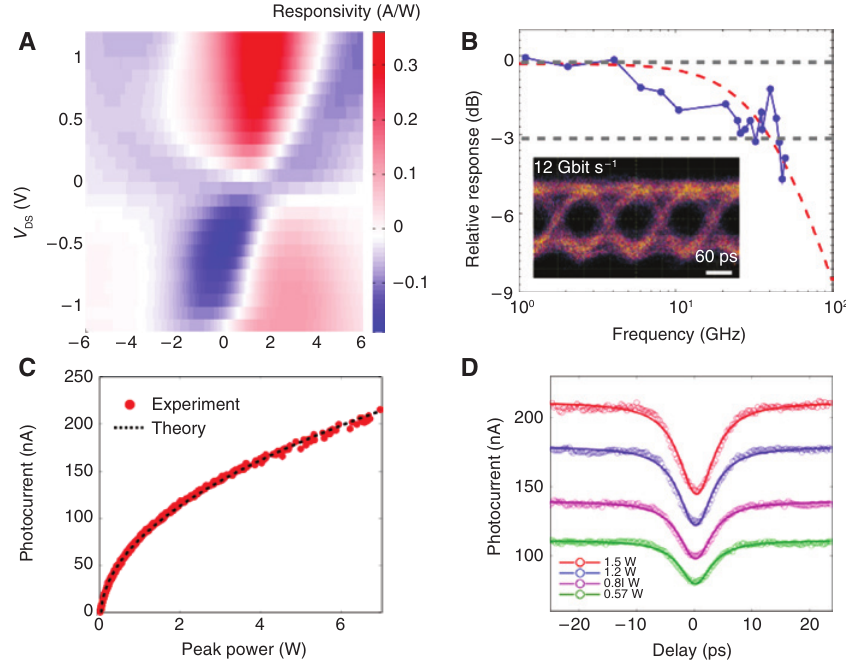
) and gate-source voltage ( V ). (B) DS GS